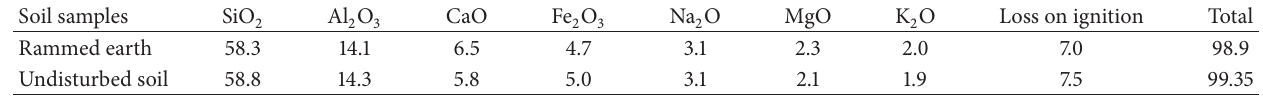
Table 3: Easily dissolved salt breakdown results of undisturbed soil samples of rammed earth and adobes. Soil samples Table 4: Physical and mechanical parameters of undisturbed soil of rammed earth and adobe.